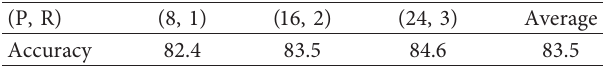
Table 9: Retrieval accuracy observed at 9 different angles at Corel 1k dataset.